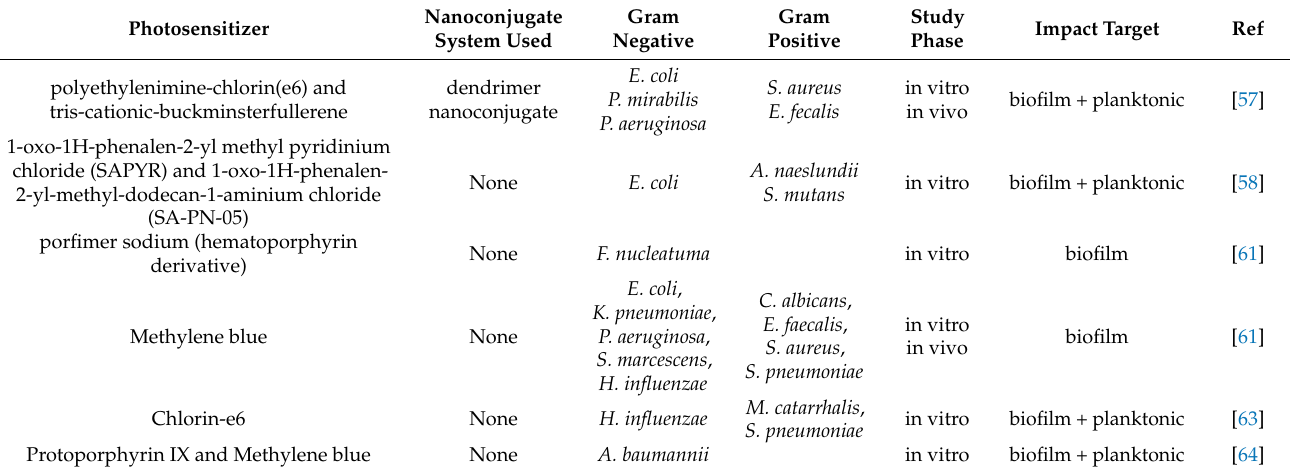
Table 1. Antibacterial photodynamic therapy